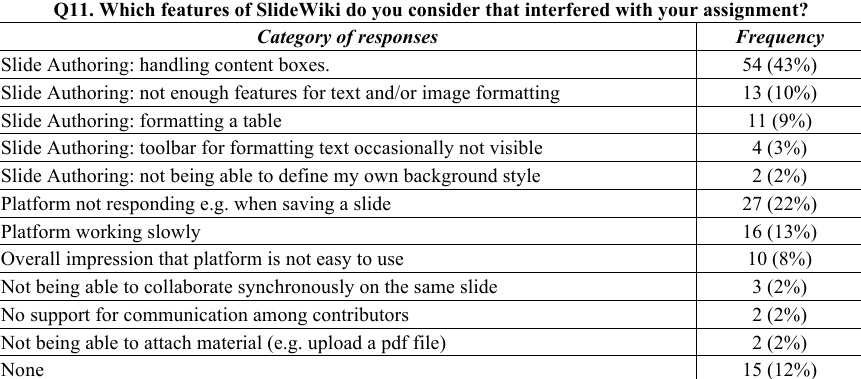
Table 3. Students’ responses to the open ended question (Q11) of Section